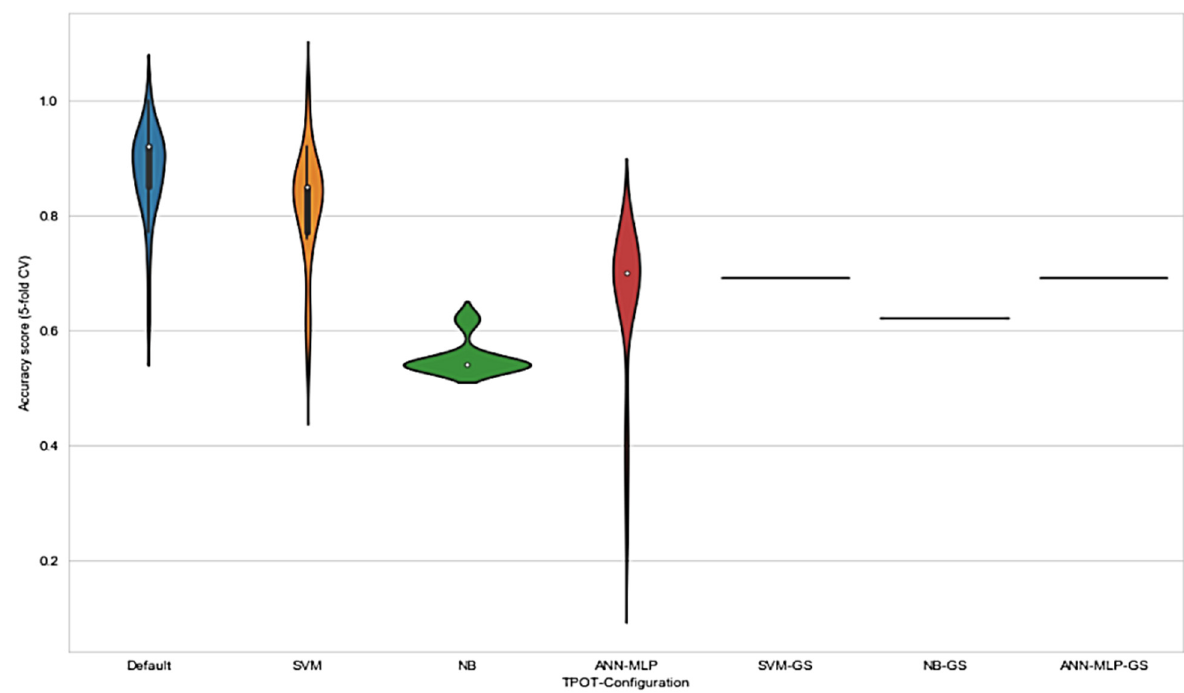
Figure 5. Distribution of accuracy scores for TPOT and grid search hyperparameter tuning deployed in various configura- tions on the radiomics data set extracted. Each distribution was of 30 experiments using the same initial TPOT configuration. Table 4. Comparative analysis of the TPOT optimization of the selected model with various metrics. Model Accuracy Precision Recall ROC AUC